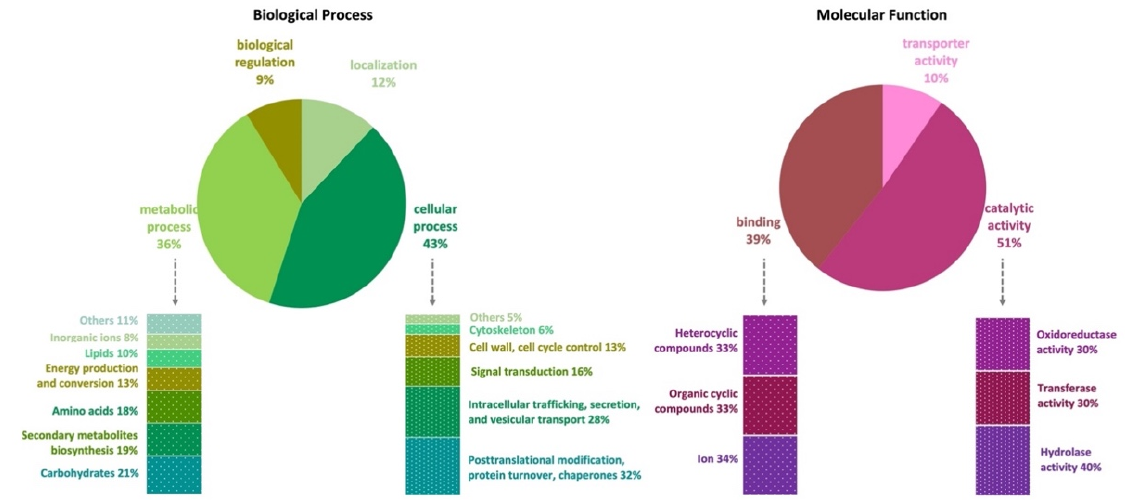
Figure 1. Gene Ontology (GO) functional annotation (pie charts) and EggNOG functional classification (bars charts) of the Aspergillus affinis CMG 70 genome.